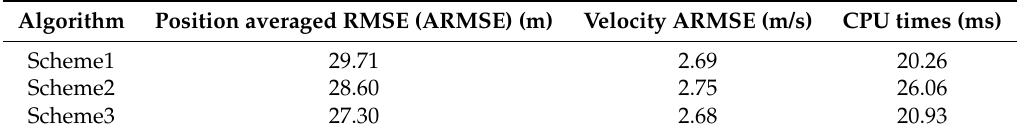
Figure 10. Performance analyses of different localization schemes from 100 independent Monte Carlo runs. ( a ) Root-mean-square errors (RMSEs) in the position estimation. ( b ) Averaged computational cost. Table 3. The performance of different